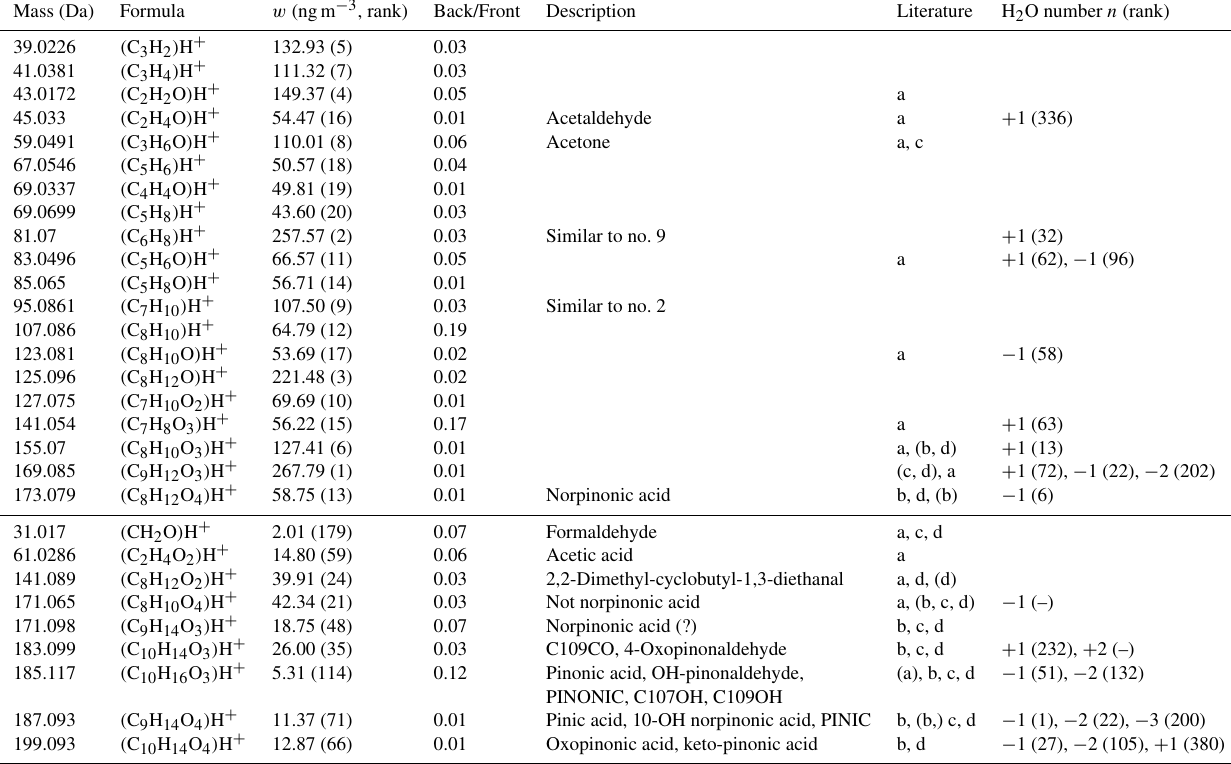
◦ C, plus 10 ions with nominal masses similar to protonated Table 4. The 20 ions with the highest concentrations from filter C1f at 150 compounds commonly reported in the literature (below the line). Ions are sorted by their measured mass ( m/z ). The chemical formula and concentration, w , are shown for each ion, and in parenthesis, its ranking out of the 451 ions. The concentration ratio between back filter C1b and the corresponding front filter (C1f) at 150 ◦ C is calculated for each listed compound. Assignments in the literature which seem to be in error are indicated by parenthesis. Ions that are part of the same sequence of the H 2 O-loss fragmentation pattern (see Sect. S4 for definition) are numbered relative to each other as ± n × 18 . 011Da ( ± n and the compound’s ranking are given). Here a dash means that the peak was identified but not resolved. The list of all ions detected from compounds desorbing from filter 6 can be found in Sect.